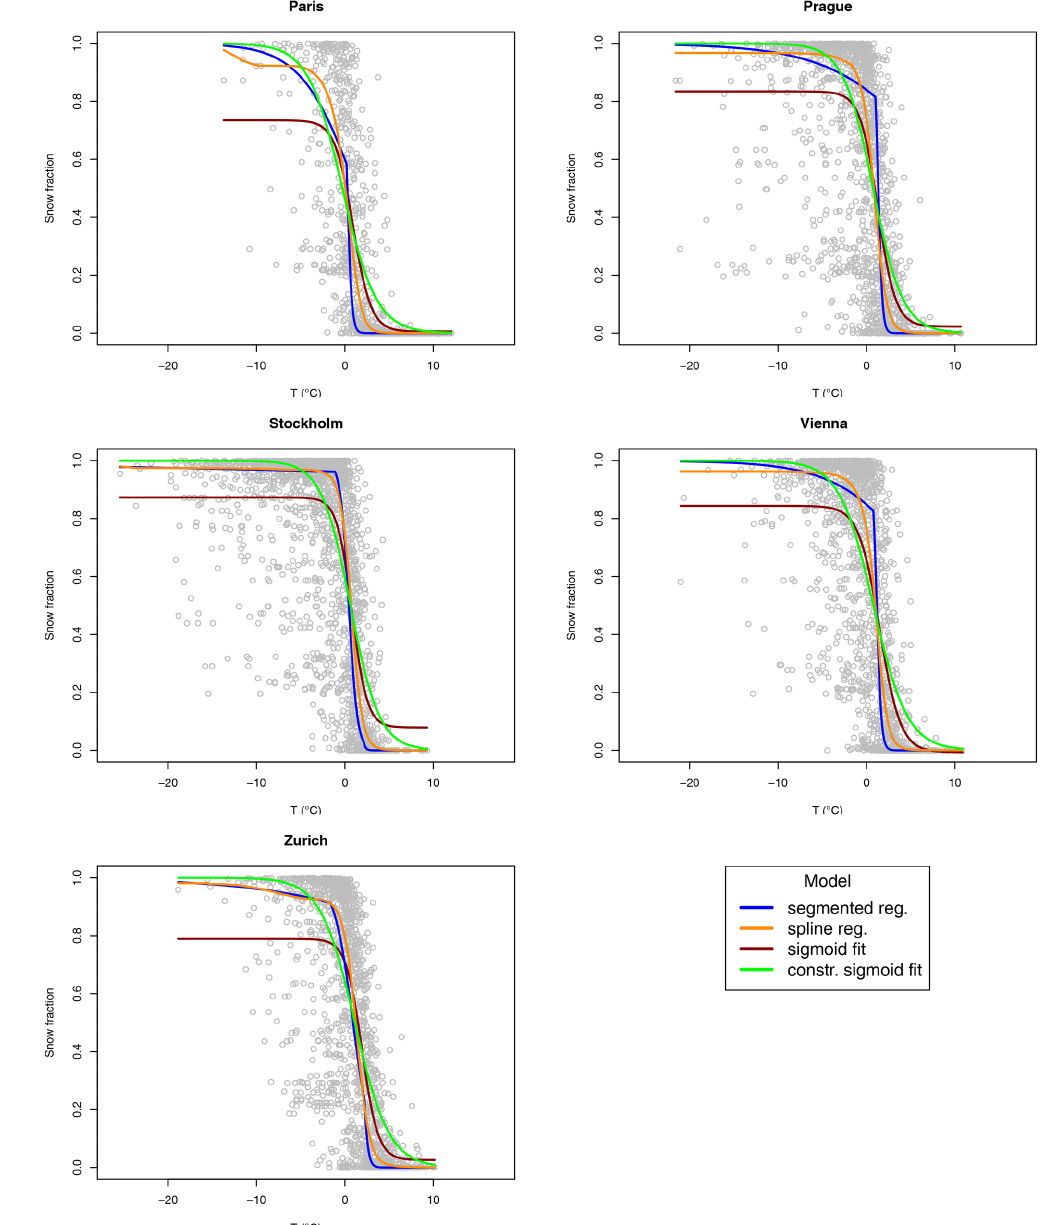
Figure 6. Snow fraction as a function of temperature for the five ERA5 grid points closest to some European cities (gray circles). Solid lines represent fitted values for the segmented logit-linear regression (blue), spline regression (orange), sigmoid fit (dark red), and constrained sigmoid fit